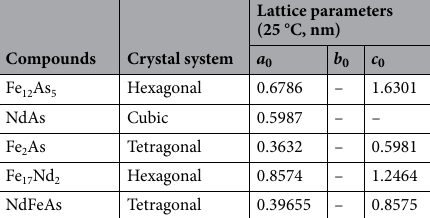
Table 4. Crystallographic parameters of possible compounds of Nd and As in steel.